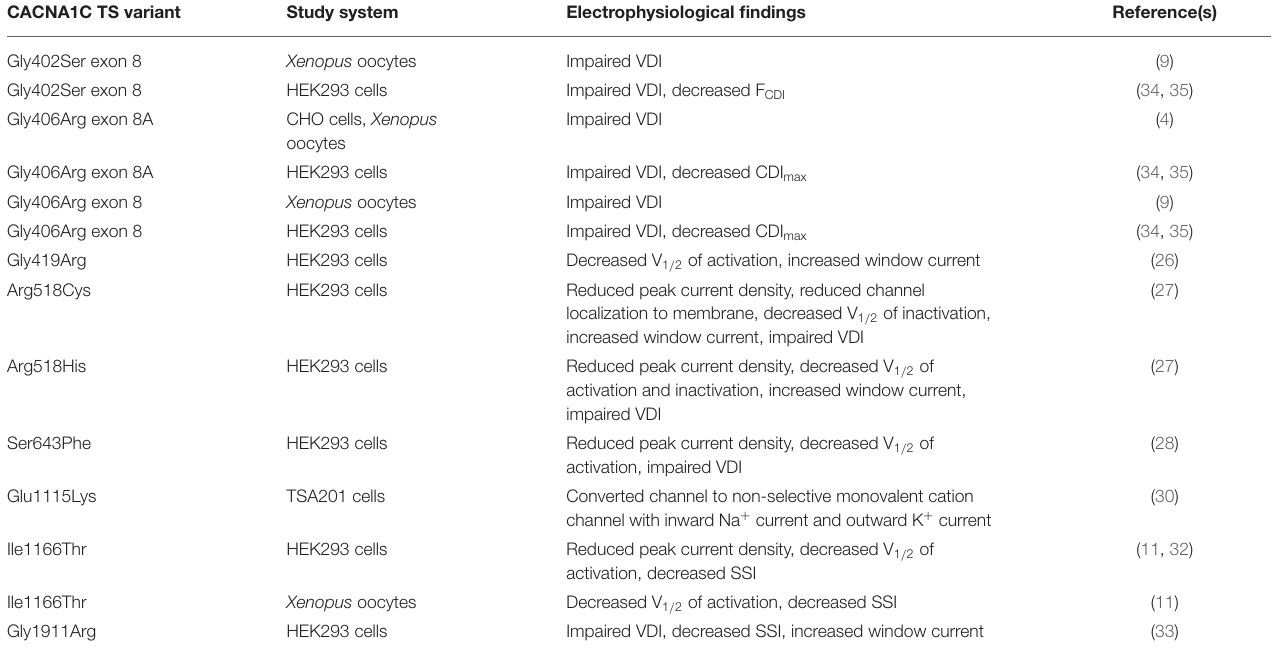
TABLE 2 | Electrophysiological effects of CACNA1C variants in model